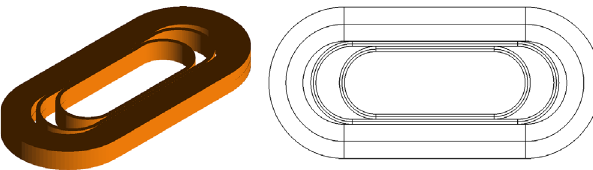
FIG. 5. Short model coil inductance as a function of the magnet current, measured at low dI=dt . The dashed line represents the computed value. FIG. 6. Views of the modeled